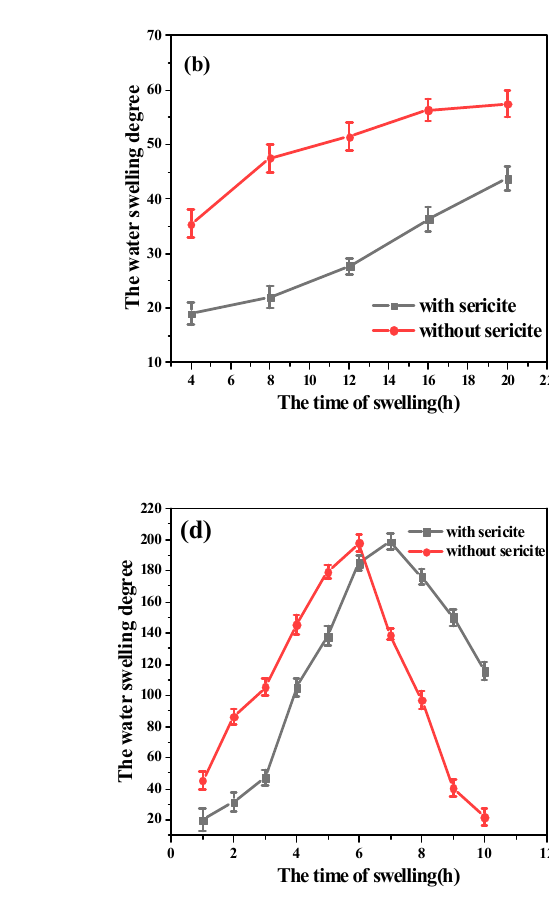
Figure 7. The swelling properties of the plugging agent in different temperatures: ( a ) 60 °C; ( b ) 90 °C; ( c ) 120 °C; ( d ) 150 °C.